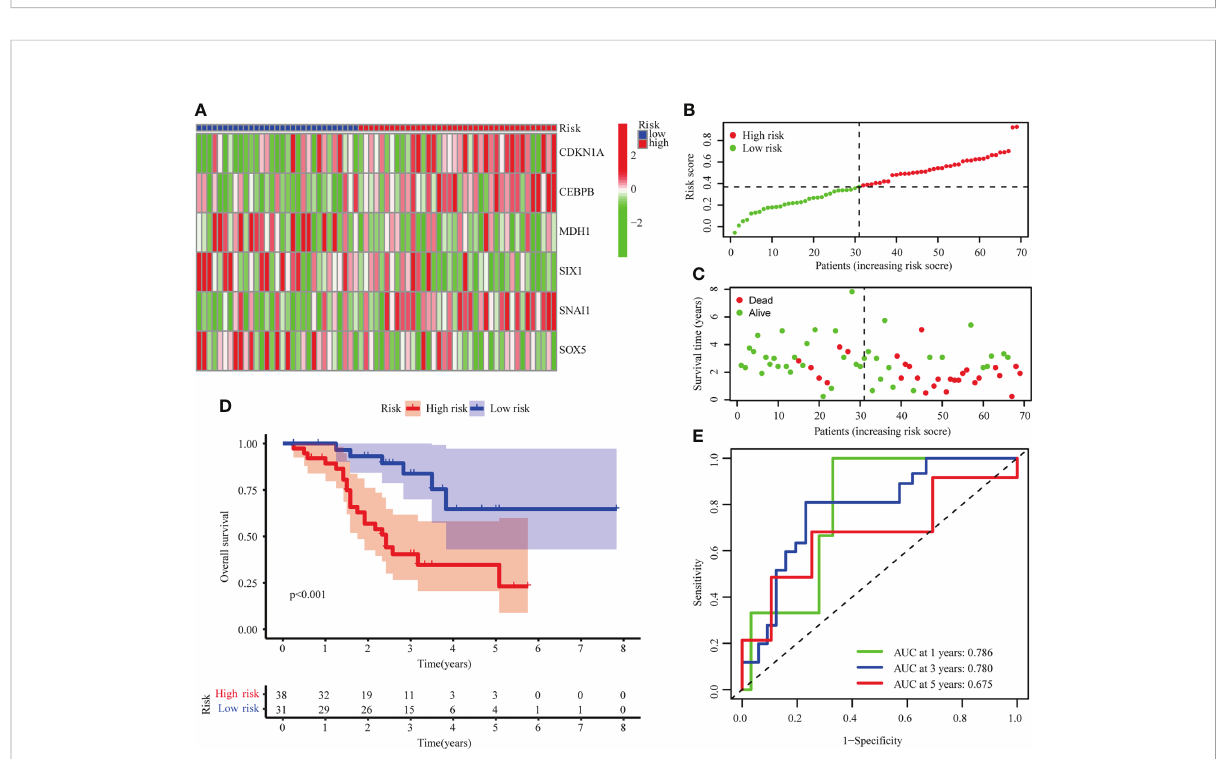
FIGURE 4 Validation of risk model in the GSE73403 cohort. (A) The heatmap of 6 hub cellular senescence-related genes. (B) The risk scores in GSE73403 cohort. (C) Distribution of survival status. (D) Survival analysis in the high risk and low risk groups. (E) AUC of the risk